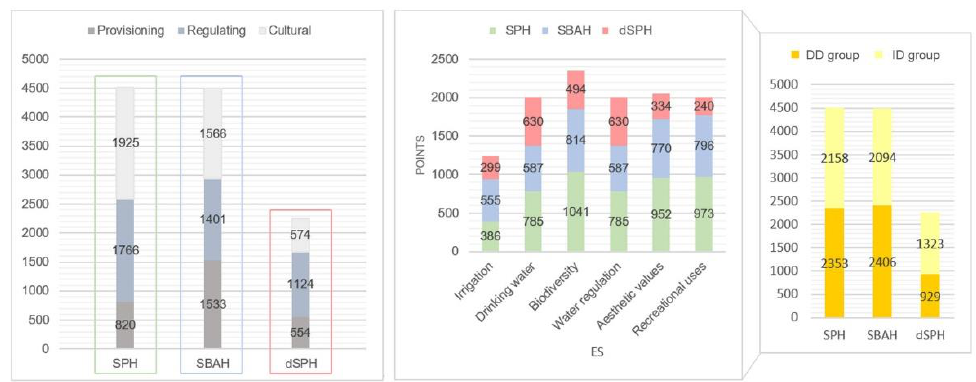
Figure 5. Distribution (number of points) of SPH, SBAH, and dSPH by water ecosystem category ( left ), unit ( center ), and stakeholder profile ( right ). DD, directly dependent; ID, indirectly dependent; dSPH, degraded service provision hotspot; SBAH, service benefiting areas hotspot; SPH, service provision hotspot.